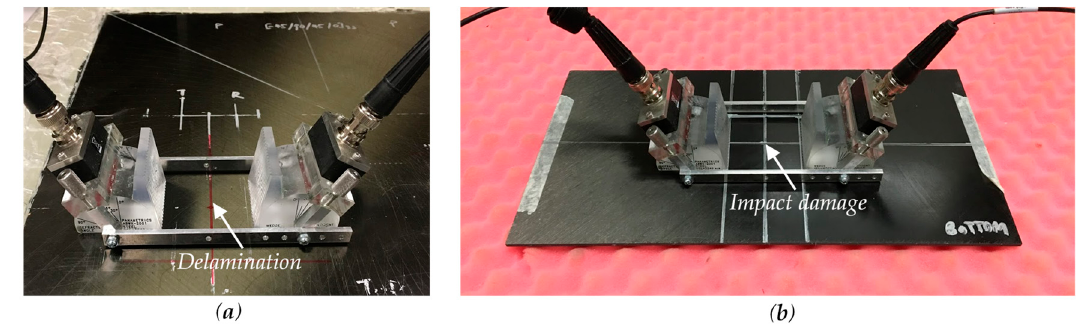
Figure 22. Experimental setup for damage detection in the 3-mm quasi-isotropic CFRP composite plate: ( a ) delamination simulated by the Teflon insert; ( b ) impact damage.